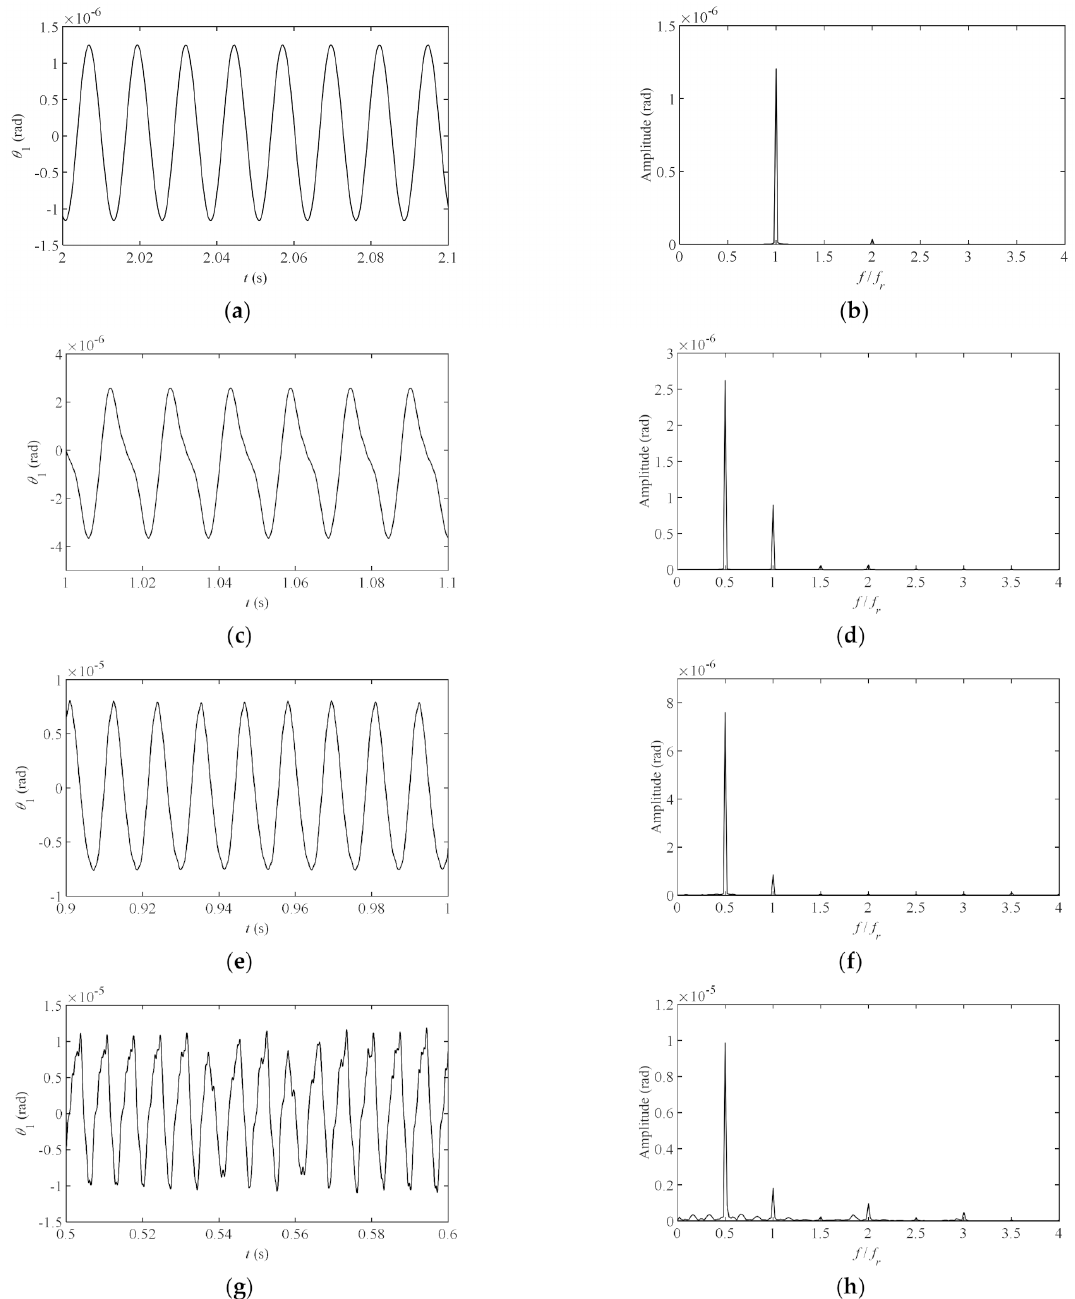
Figure 7. Time domain and spectrum diagram at different speeds: ( a ) Time domain curve at 500 rad/s; ( b ) Spectrum diagram at 500 rad/s; ( c ) Time domain curve at 800 rad/s; ( d ) Spectrum diagram at 800 rad/s; ( e ) Time domain curve at 1100 rad/s; ( f ) Spectrum diagram at 1100 rad/s; ( g ) Time domain curve at 1800 rad/s; ( h ) Spectrum diagram at 1800